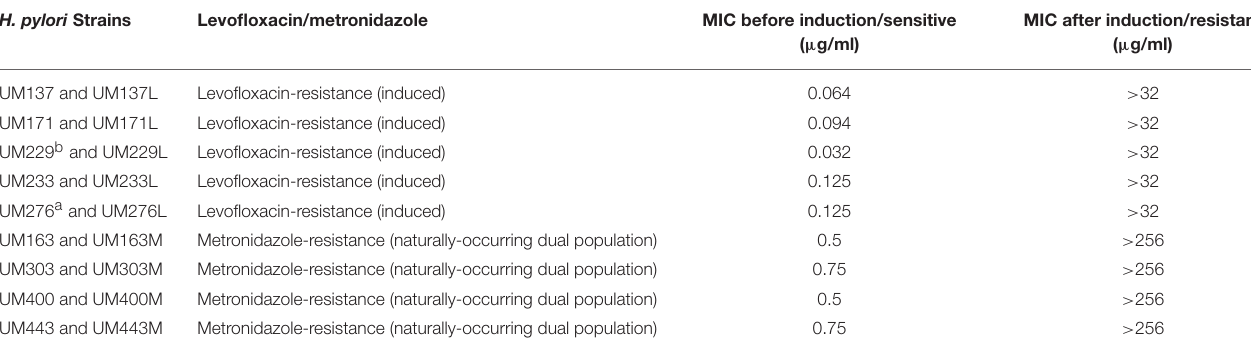
TABLE 1 | MICs of H. pylori strains before and after levofloxacin-resistance in vitro induction (UM137, UM171, UM229, UM233, and UM276) and naturally-occuring metronidazole-sensitive and resistant H. pylori strains (UM163, UM303, UM400, UM443). H. pylori